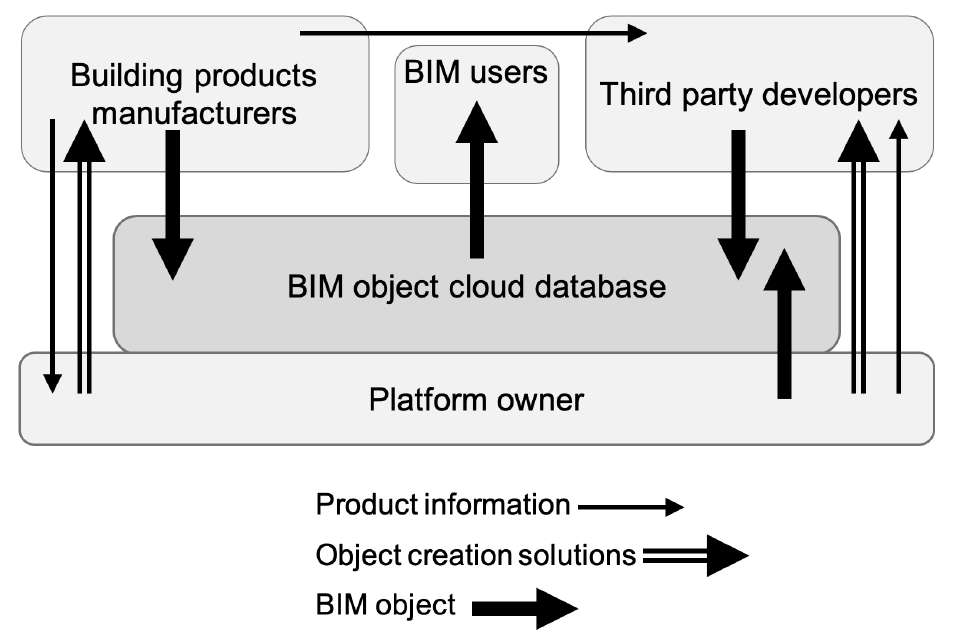
Fig. 5. Interactions on platform